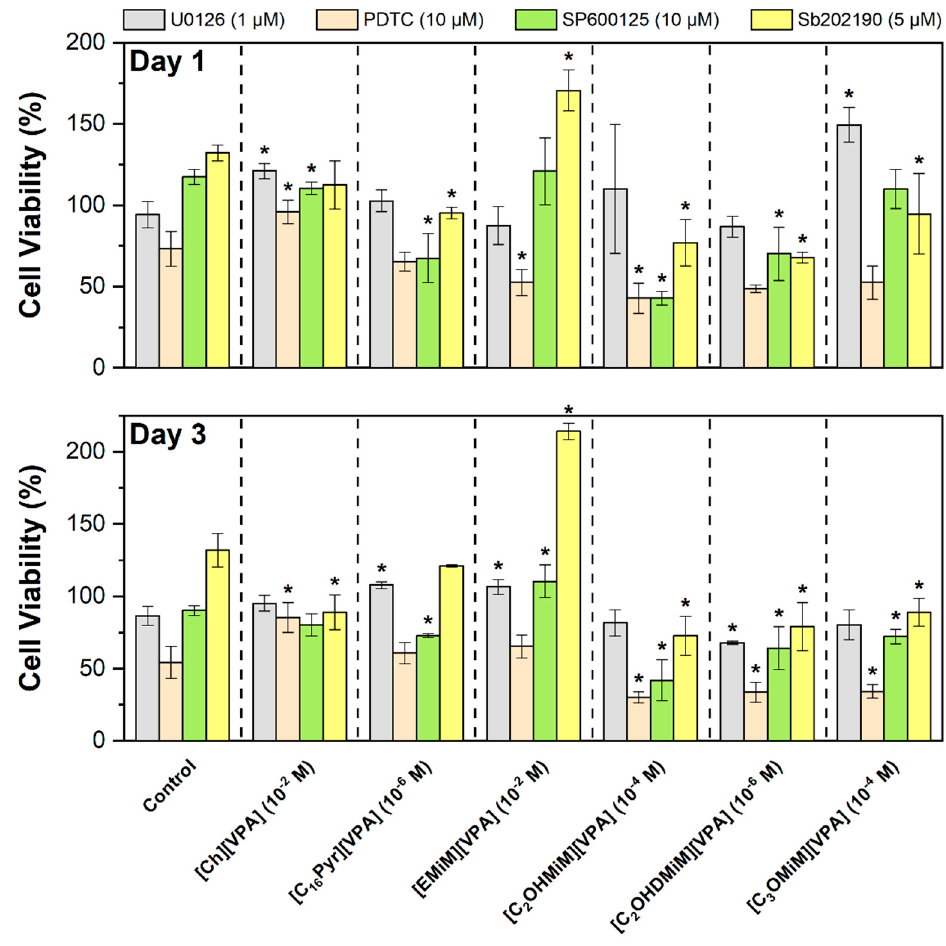
Figure 2. Cell viability in cultures of SH-SY5Y cells supplemented with different inhibitors of cell- signaling pathways: U0126, PDTC, SP600125 and Sb202190, which are the inhibitors of the MEK, NFkB, JNK and p38 pathways, respectively. The results are presented using as internal control the value obtained in the absence of any inhibitor for each ILs-API experimental condition. Error bars are also provided, corresponding to the standard deviation of the three replicates, whose asterisk highlights the data significantly different from the control ( p < 0.05).